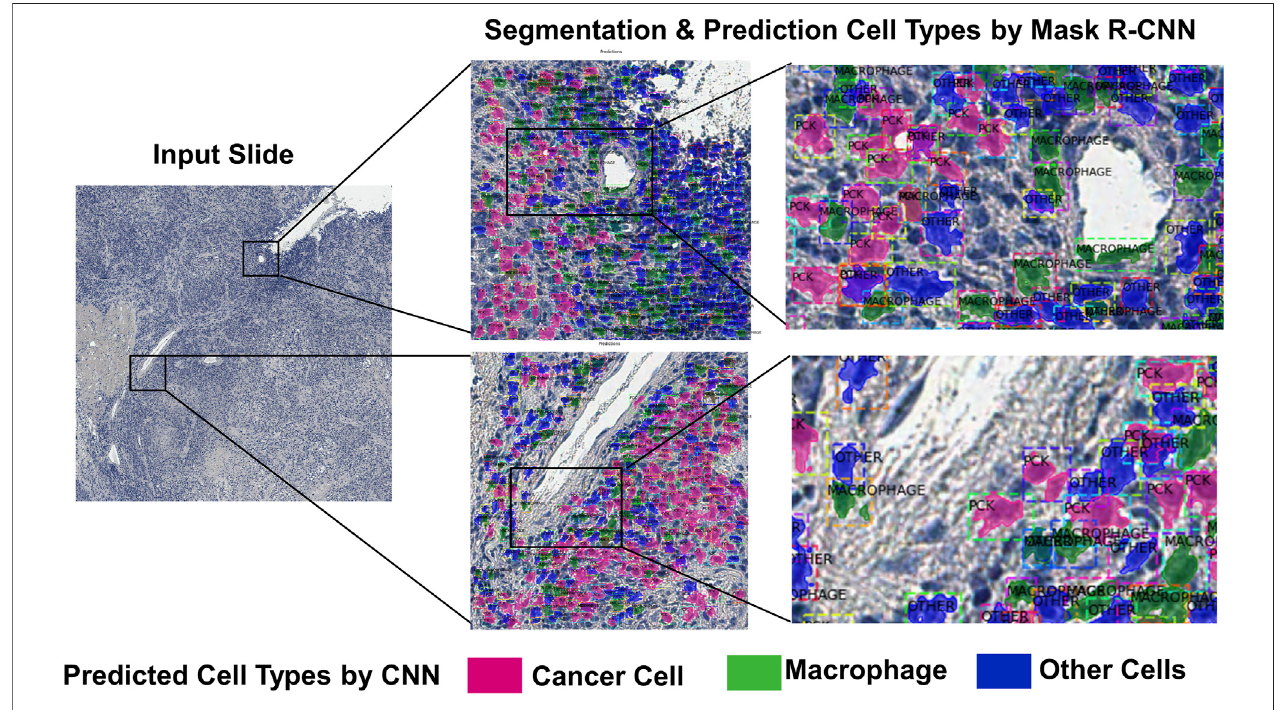
FIGURE 4 | An example of the deep learning-based cell subtype prediction